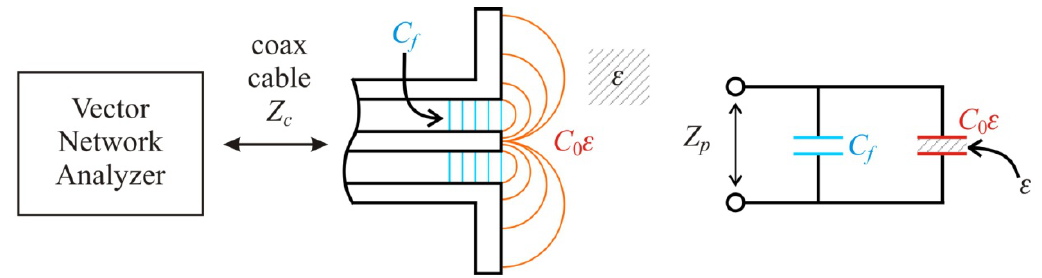
– C of an open-ended coax f 0